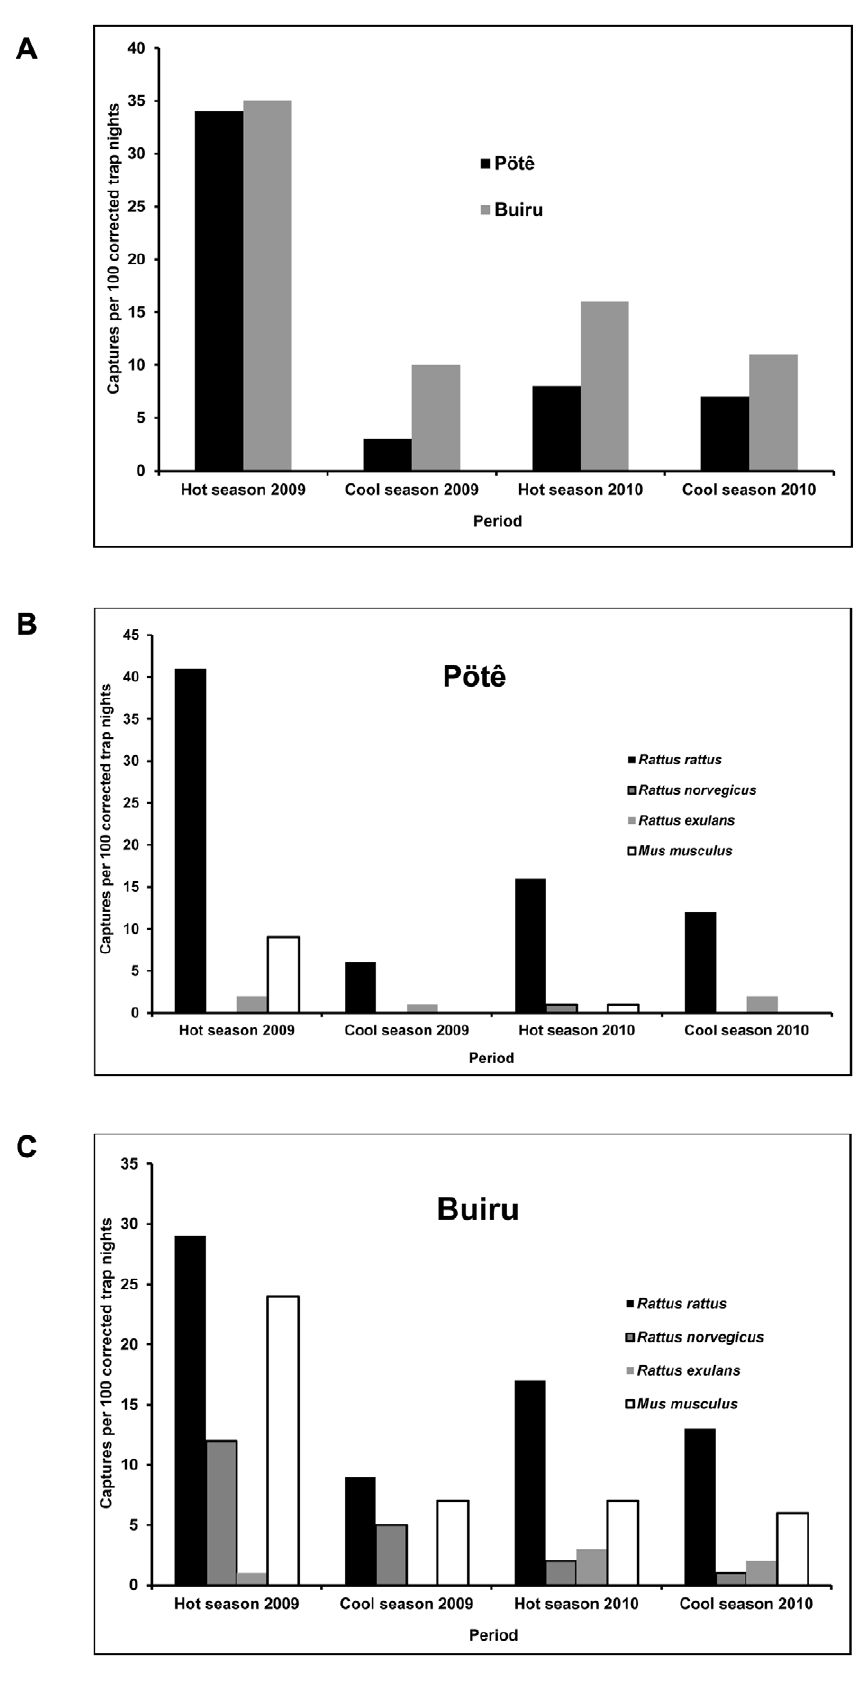
Figure 4. Abundances indexes in each tribe at the different seasons.